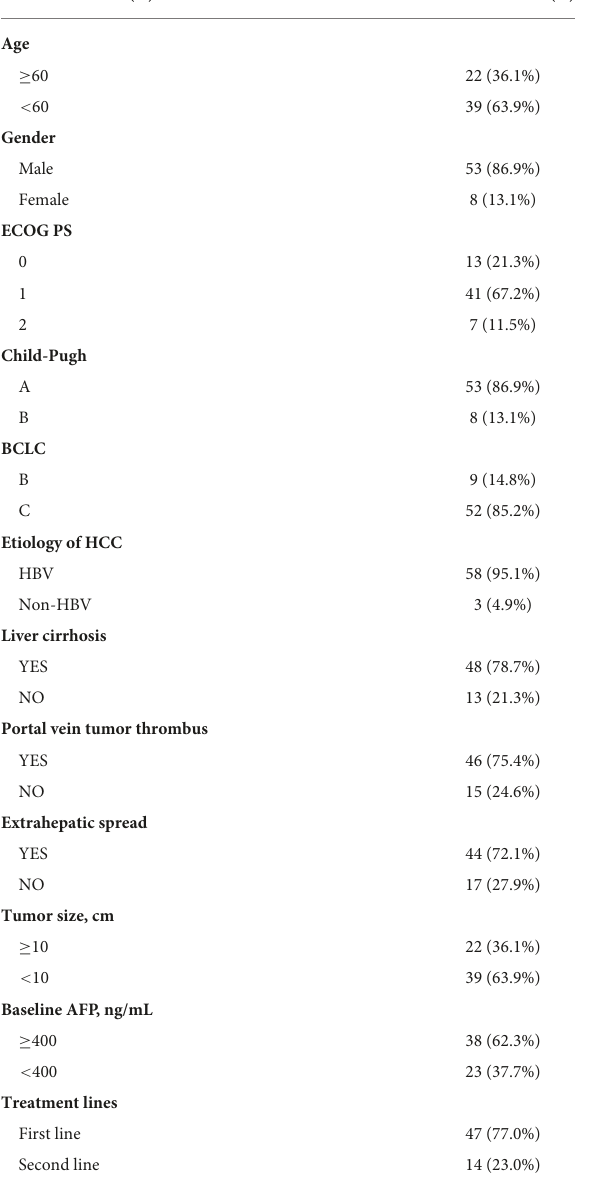
TABLE 3 Number of patients who received subsequent treatments.